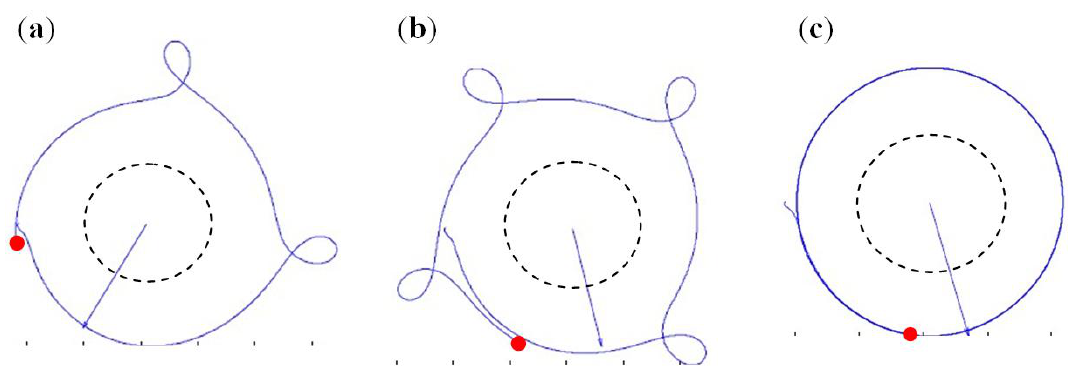
Figure 6. Trajectories of magnetic beads moving around static disks in a rotating magnetic field. ( a ) A bead completes one period around the disk during about three periods of the magnetic field (f = 8000 RPM, B = 0.063 T). ( b ) A bead completes one period around the disk during about four periods of the magnetic field (f = 10,000 RPM, B = 0.074 T). ( c ) A bead rotates with the frequency equal to that of the external magnetic field and follows nearly circular trajectory around the disk (f = 8000 RPM, B = 0.13 T). The dotted line shows the outer contour of the static disk. The dot indicates the final position of the